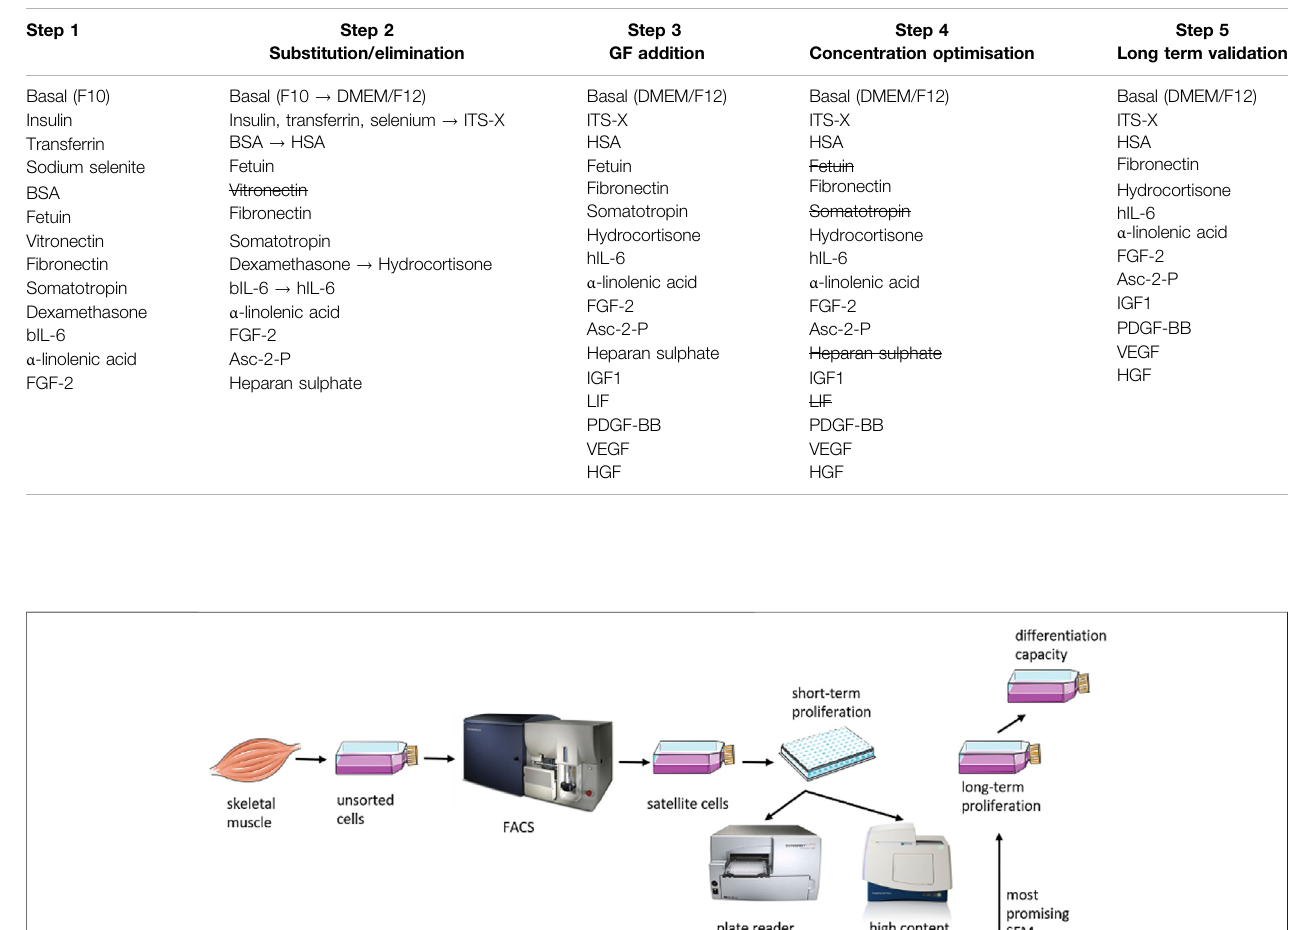
TABLE 1 | Overview of the 5-step methodology for the animal-free medium development.